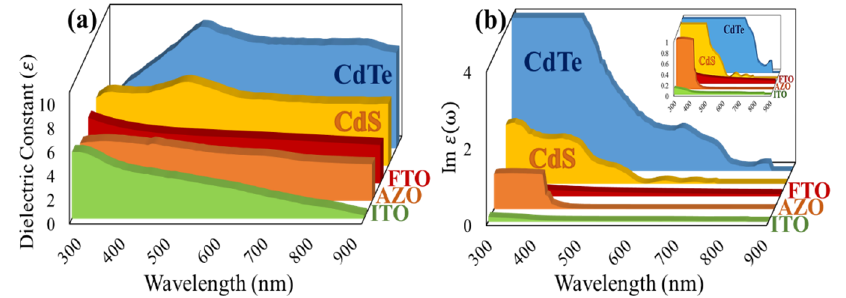
Figure 7. (a ) Real and ( b ) imaginary part of the dielectric constant for the CdTe thin